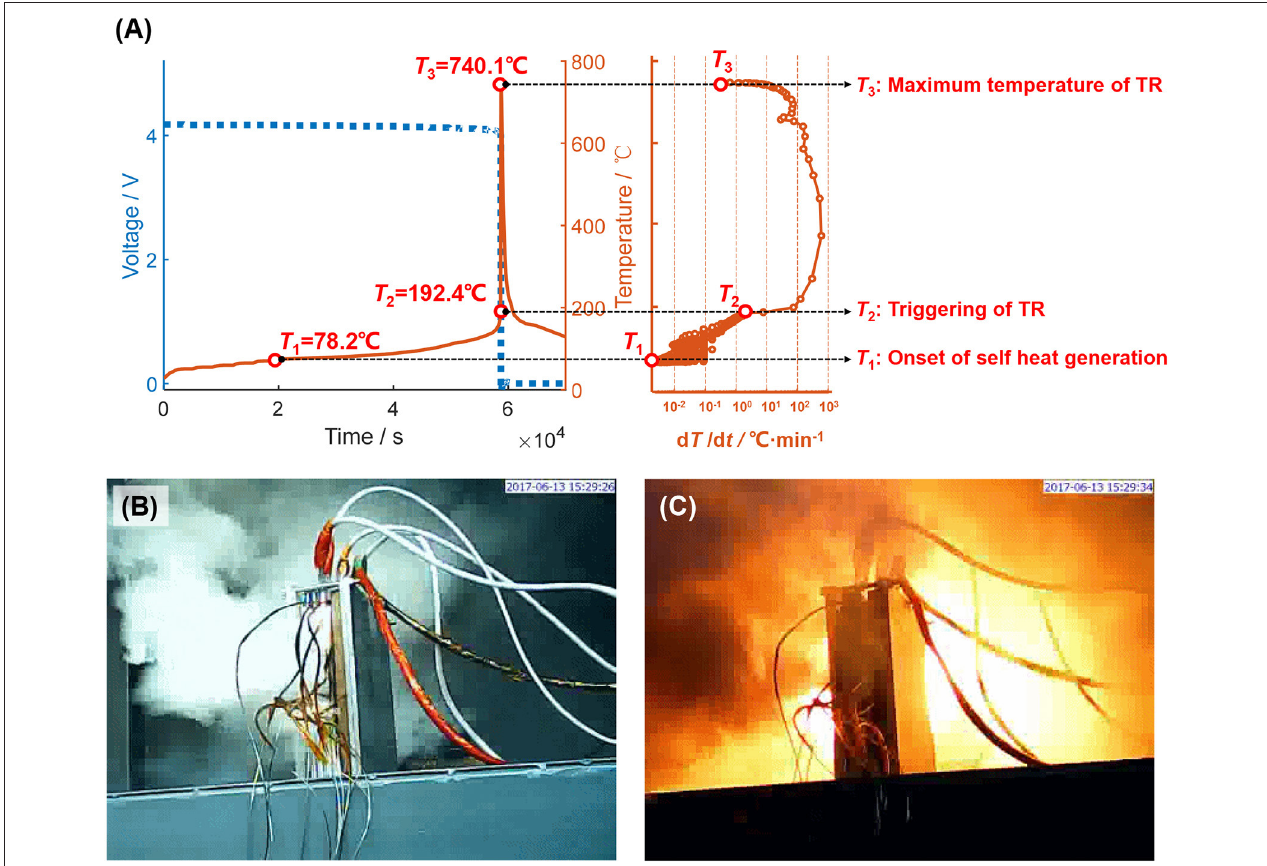
FIGURE 2 | Key characteristics for battery TR, data from Battery Sample A. (A) Characteristic temperatures for a TR during ARC test; (B) Smoke during a TR test; (C) Fire during a TR test.